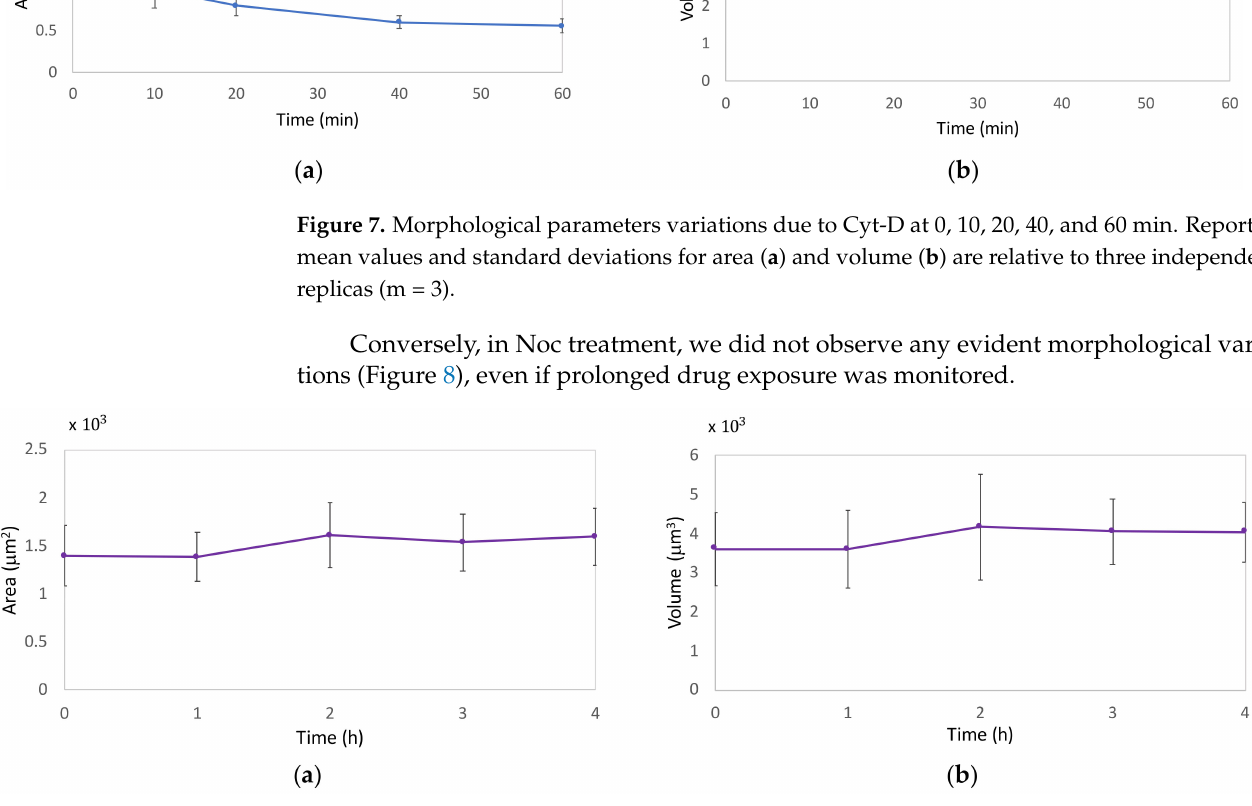
Figure 8. Morphological parameters variations due to Noc at 0, 1, 2, 3, and 4 h. Reported mean values and standard deviations for area ( a ) and volume ( b ) are relative to three independent replicas (m =